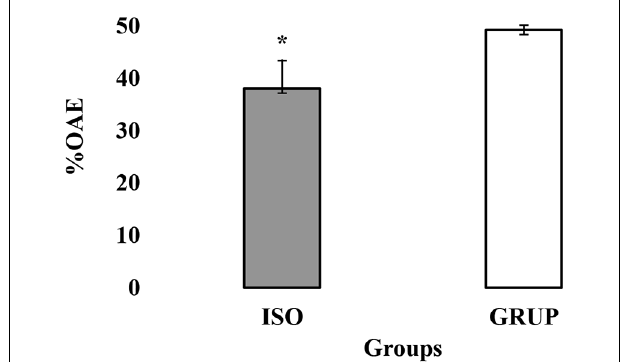
FIGURE 1 | Consumption of pure water and 32% sucrose solution by groups on D1, D2, D3, and D4. Average consumption (PROM ± EE) of pure water vs. 32% SS on D1, D2, D3, and D4, of the groups ISO32% (isolated 32%); GRUP32% (grouped 32%); ISOH2O (isolated water); and GRUPH2O (grouped water). ∗ Higher consumption of 32% SS tan water in isolated D1, D2, D3 y D4. ∗∗ Higher consumption of 32% SS in isolated and grouped on D4 than D1, D2, and D3 (Holm–Sidak Test t, p < 0.05).